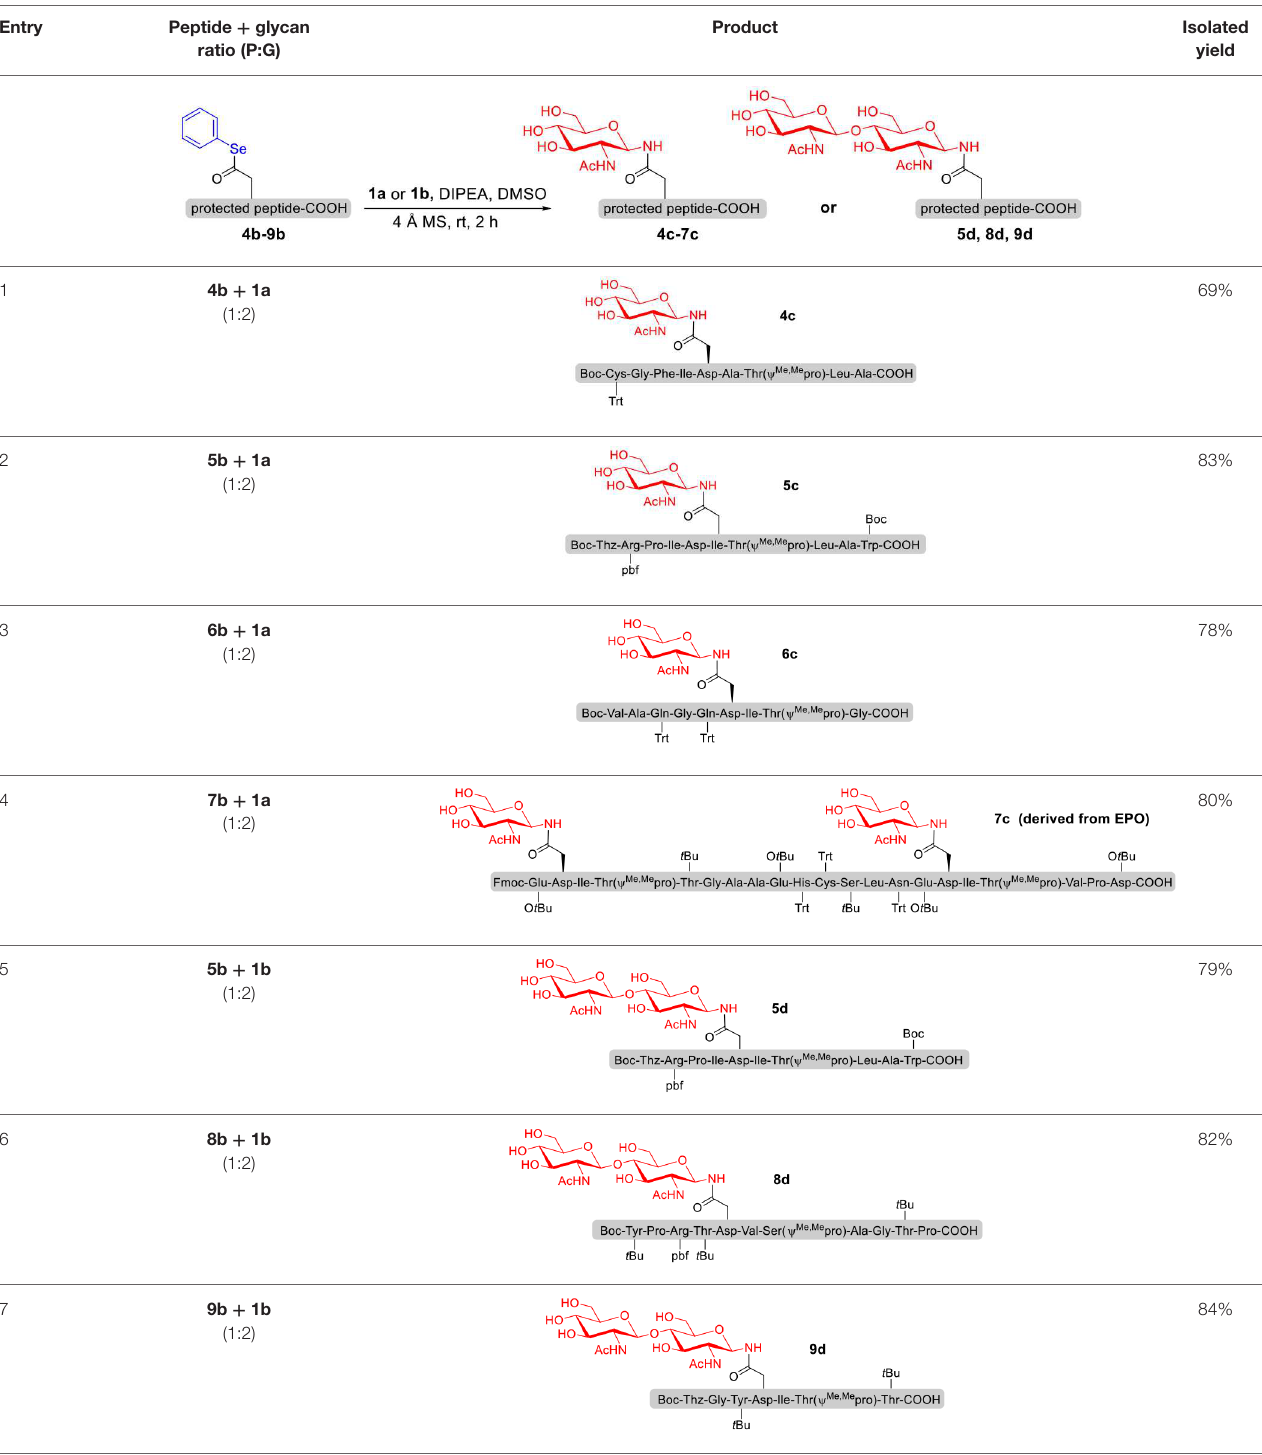
Product Isolated